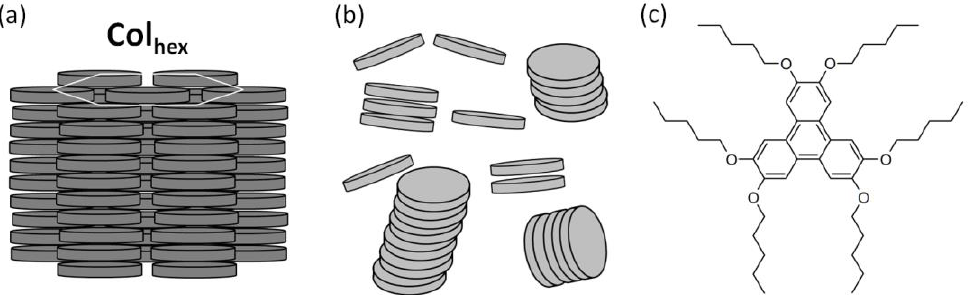
Figure 1. ( a ) Schematic representation of the columnar hexagonal (Col hex ) mesophase (single- component system). The white hexagon underlines the lateral arrangement of supramolecular columns, with hexagonal symmetry being the most common. ( b ) Schematic representation of the aggregation of discotic molecules in solution (two-component system, under investigation). Solvent molecules not shown. ( c ) Structural formula of 2,3,6,7,10,11-hexapentyloxytriphenylene (H5T), the discotic mesogen under investigation.